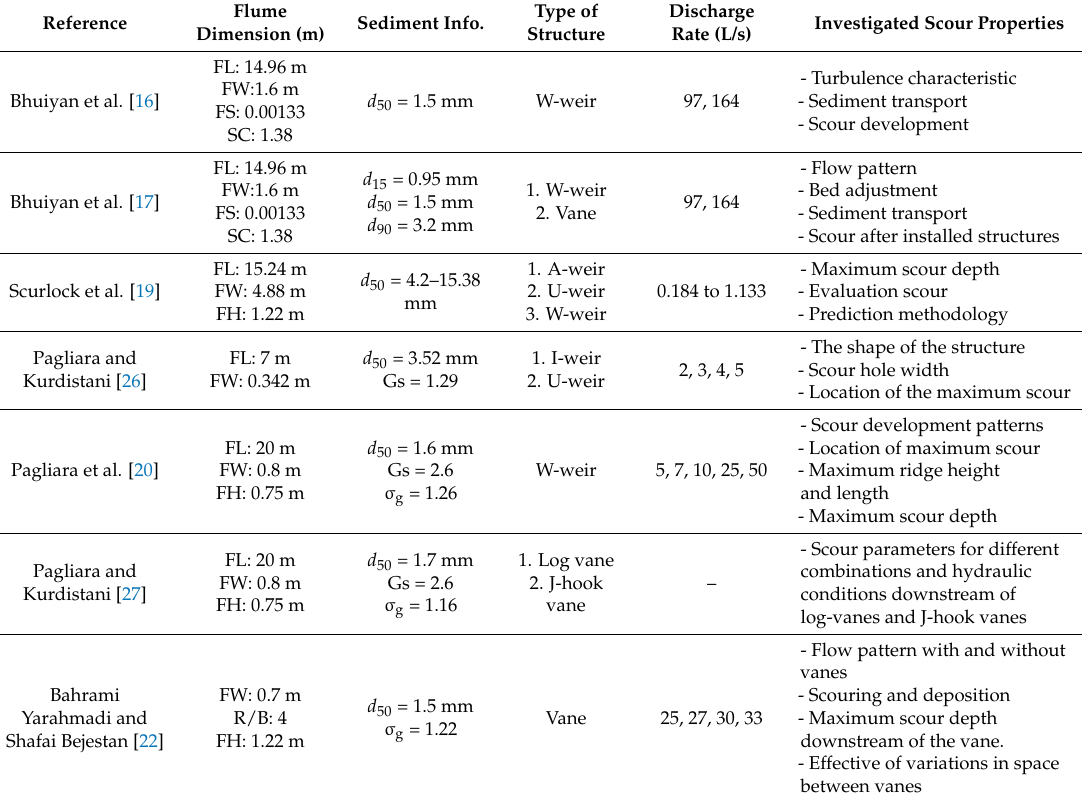
Table 1. Past experimental studies on